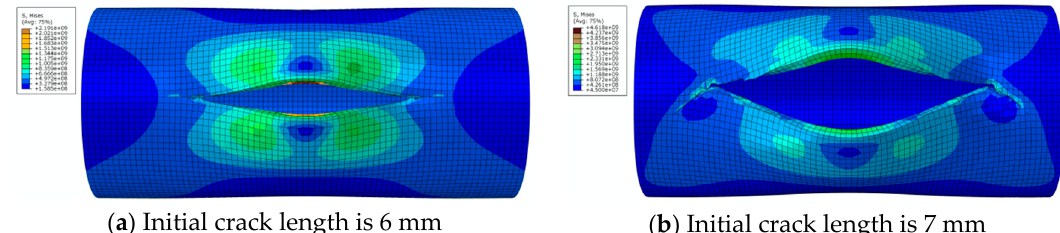
Figure 10. The von Mises stress distribution under different initial crack lengths, where the internal pressure is 35 MPa (here, images are magnified 10 times for visual display).